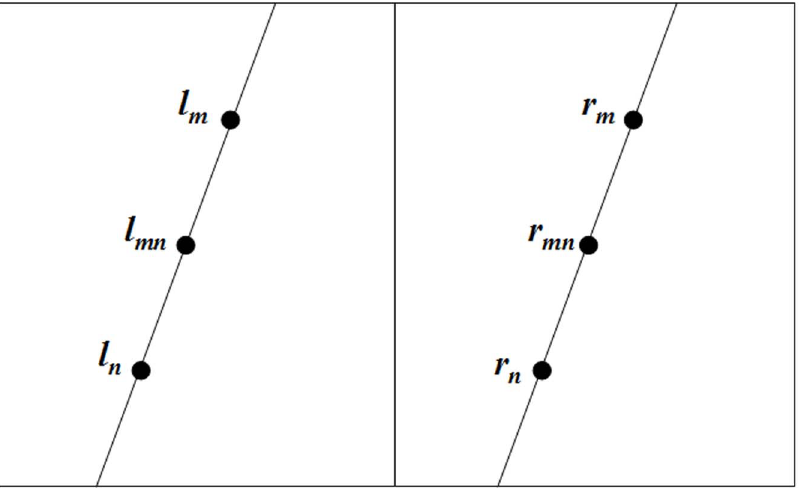
Figure 2. Two initially matching-corner pairs, (l m ,r m ) and (l n ,r n ) , along with their respective midpoints: l mn between l m and l n and r mn between r m and r n .